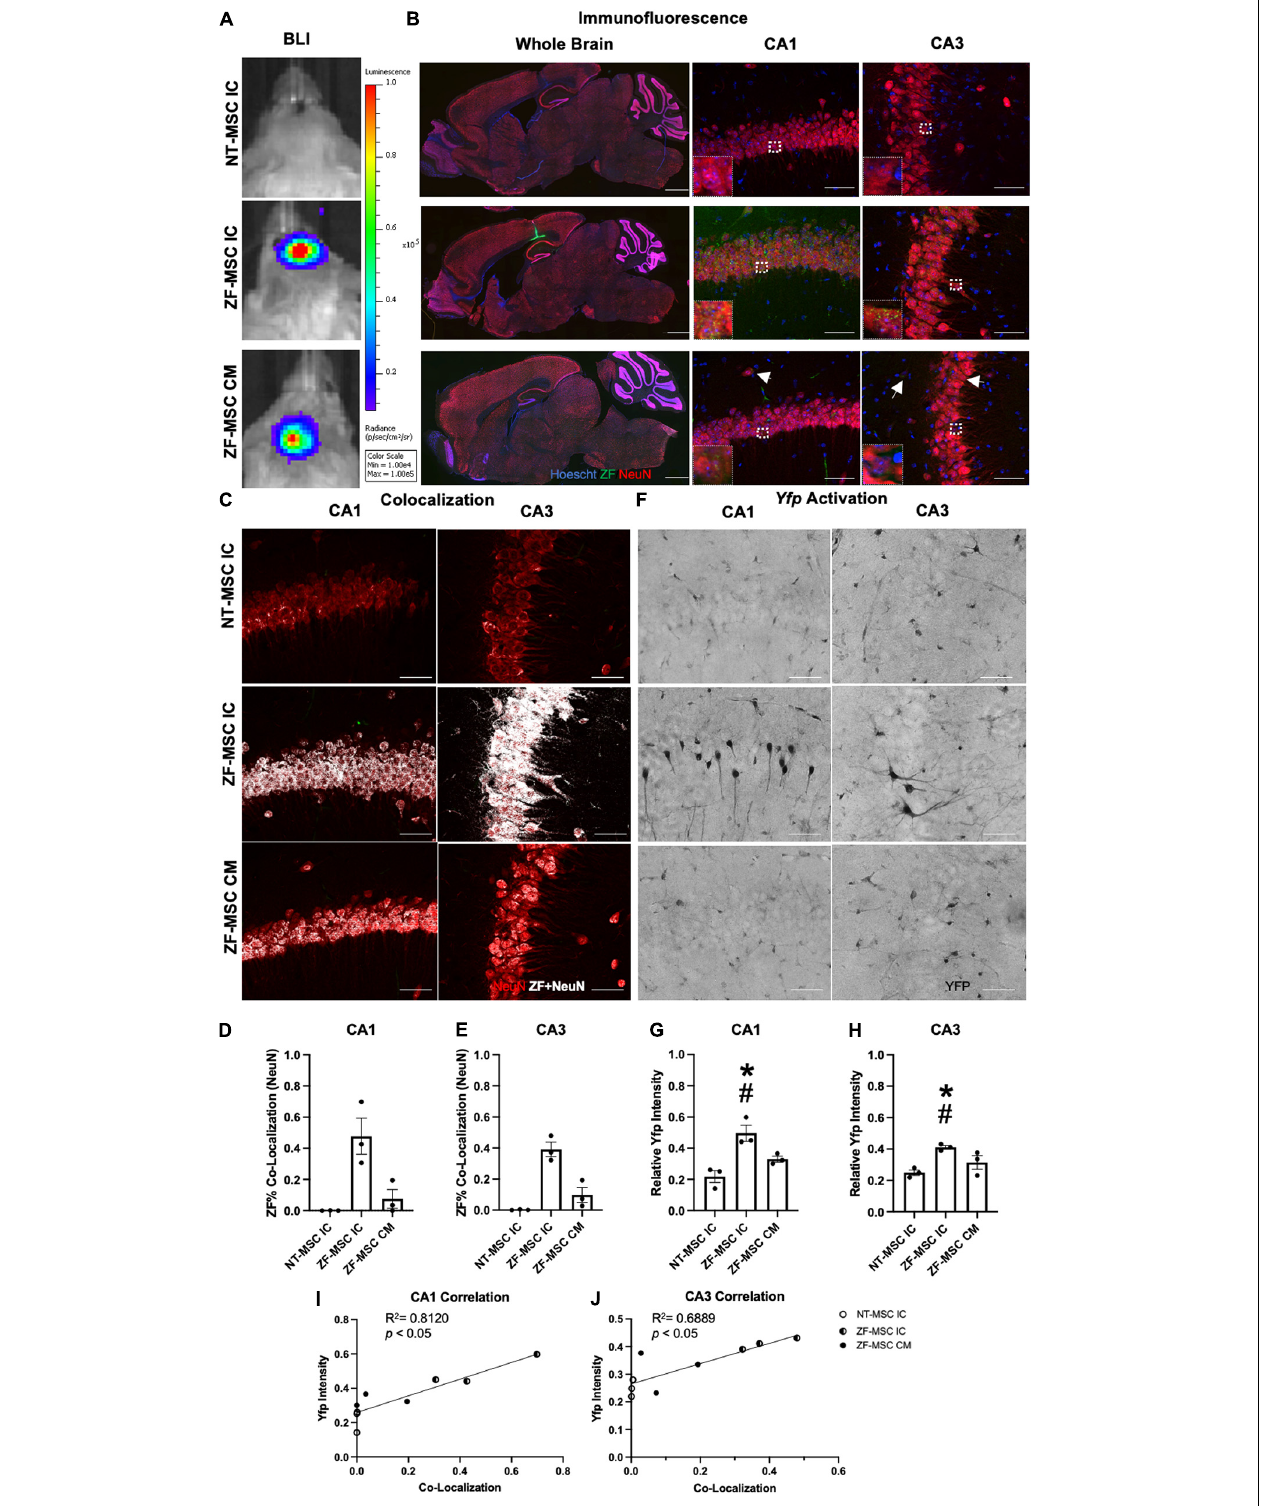
FIGURE 4 | ZF-MSC persist 1 week following injection and demonstrate In vivo protein uptake. (A) Transduced ZF-MSC are detectable at the surgical site within the brain (ZF-MSC IC) or at the base of the skull (ZF-MSC CM) via bioluminescent imaging (BLI) 7 days following administration. (B) (Left Column) Bolus of ZF-MSCs (green) were observed within the corpus callosum, dorsal to the hippocampus of IC-injected mice 7 days following transplantation. Scale bar = 1,000 µ m.